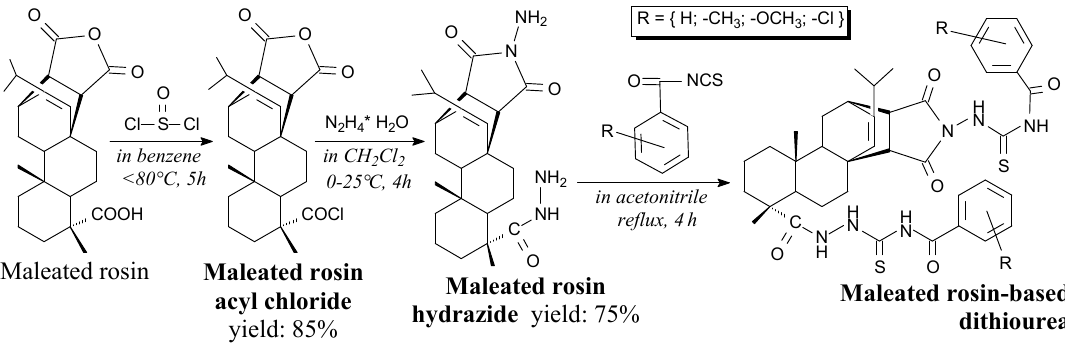
Scheme 43. Synthesis of maleated rosin-based dithiourea compounds.